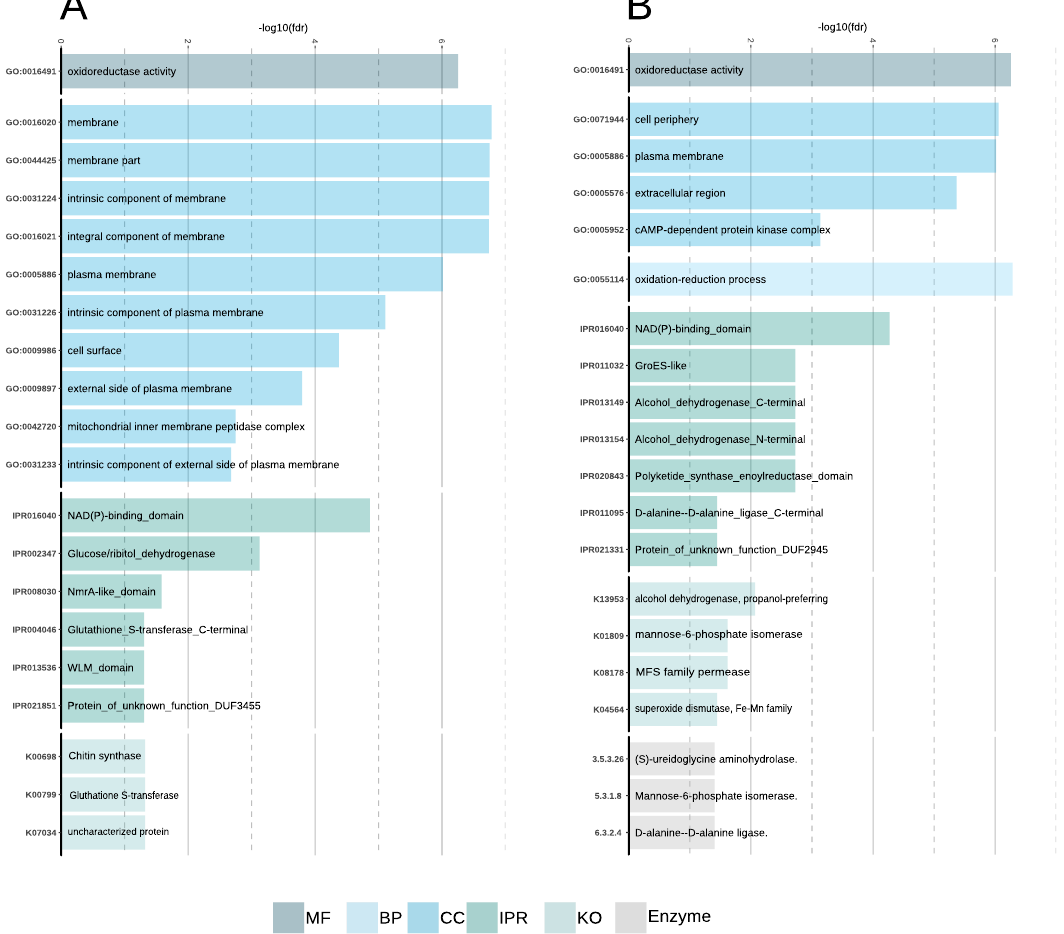
Figure 6. Bar plots showing overrepresented functional annotations in the set of regulated genes in A. salisburgensis . ( A ) Enriched functional terms in the set of downregulated genes. ( B ) Enriched functional terms in the set of upregulated